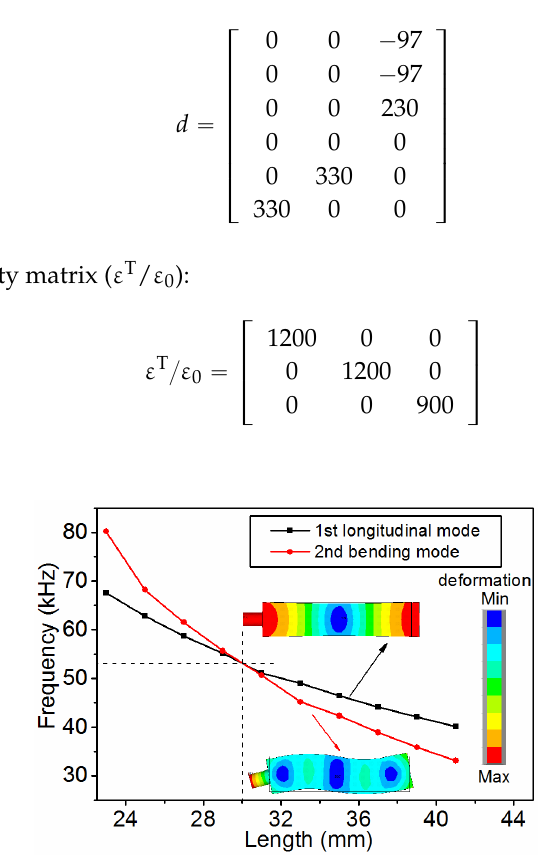
Figure 4. Modal frequencies at various lengths of PZT (piezoelectric lead zirconate titanate) block. According to the FEA results, the final dimensions are decided to be 30 × 7.5 × 3 mm 3 , as mentioned previously. The dimension of the alumina ceramic contactor is Φ 3 × 4 mm. A photo of the piezo ‐ vibrator is shown in Figure 5.